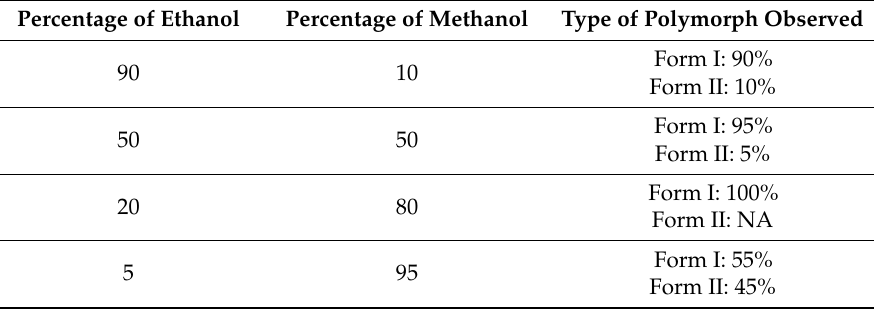
Table 6. Results of Crystallization in Mixed